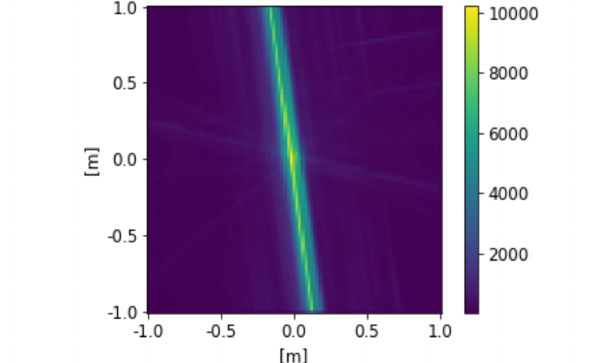
Figure 5. Maximum consensus accumulator for the point cloud depicted in Figure 4.